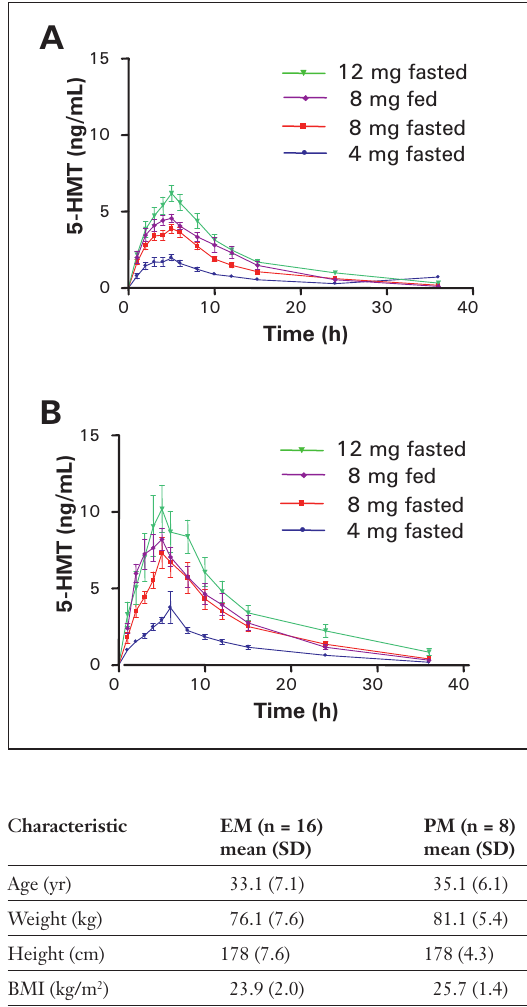
Plasma concentra- tions of 5-HMT after administration of feso- terodine in rapid (A) and slow (B) metabolisers. Data are presented as means ± standard error of the mean (SEM).